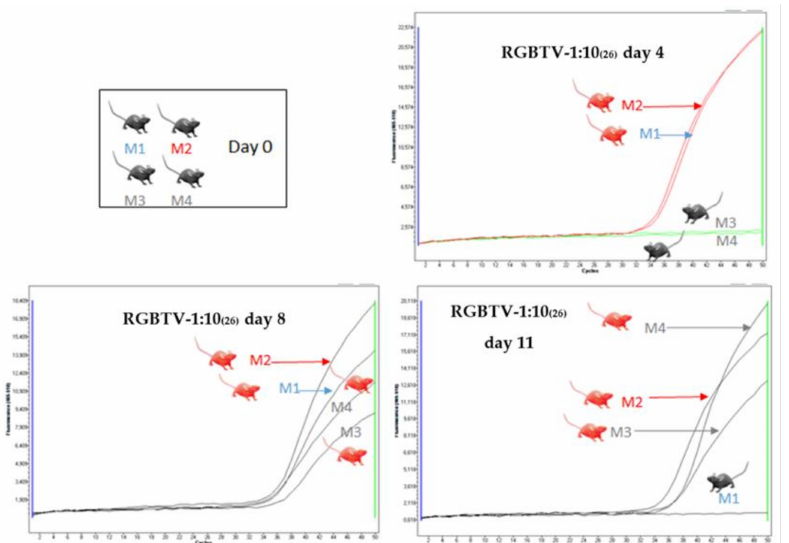
Figure 7. Real-time RT-PCR amplification curves of RNA extracts from blood samples of mice inoculated with BTV-1:10 (26) . On day 4 both inoculated mice (M1 and M2) were positive by real-time RT-PCR. On day 8 and 11 both in-contact mice (M3 and M4) were positive for BTV RNA. In one of the experiments, one mouse (M1) which was inoculated on day 0, became negative on day 11 of the